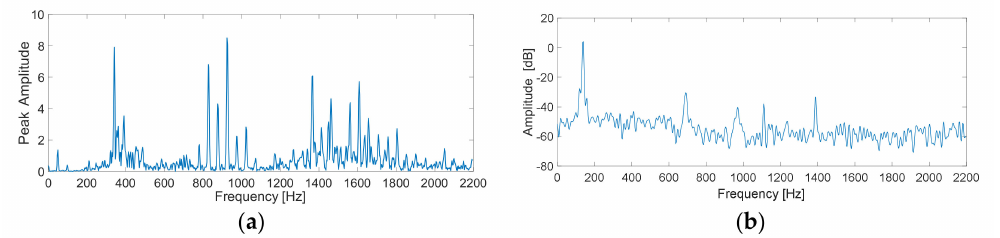
Figure 6. Corresponding spectra of: ( a ) vibration and ( b ) current